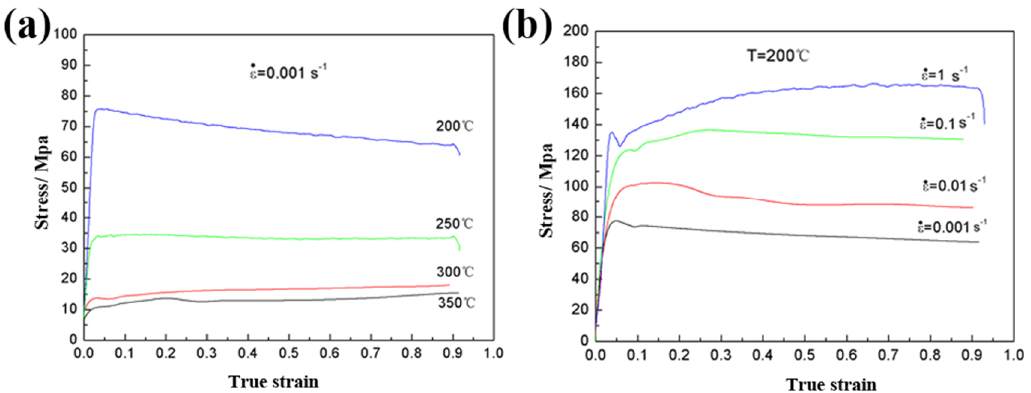
Figure 3. The true stress–strain curves of the 0.05 wt.% ND/ZK60 composite deformed at different strain rates and deformation temperatures. ( a ) The true stress–strain curves of composite deformed under different temperatures at strain rate of 0.001 s −1 ; ( b ) The true stress–strain curves of composite deformed under different strain rate at 200 ℃.